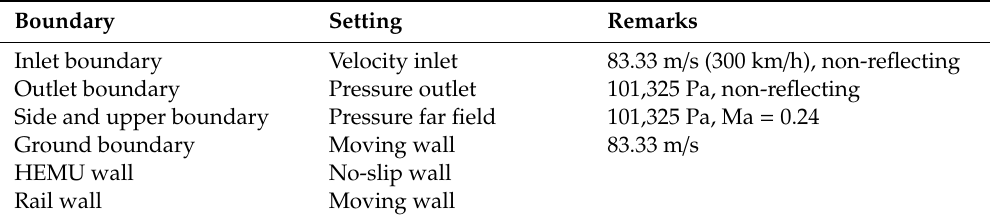
Figure 3. Target train model (HEMU-430X) and its main parts.